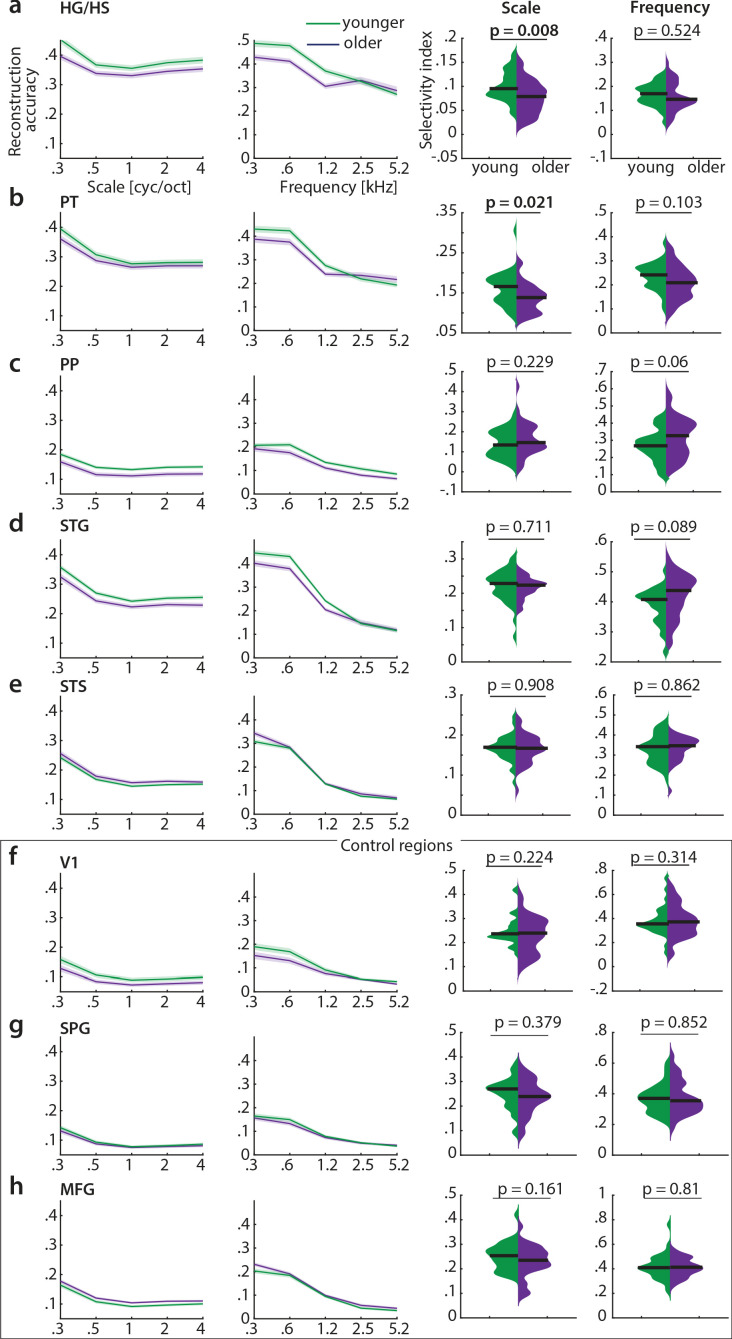
Decoding of spectral scale and frequency in ROIs.Mean (± SE) reconstruction accuracy profiles (left) and selectivity index (right) per age group for spectral scale and frequency in (a) Heschl’s gyrus and sulcus (HG/HS), (b) planum temporale (PT), (c) planum polare (PP), (d) superior temporal gyrus (STG), (e) superior temporal sulcus (STS) and the control regions (f) calcarine sulcus (V1), (g) superior parietal gyrus (SPG) and (h) middle frontal gyrus (MFG). Selectivity index was compared per ROI between age groups using exact permutation test. Black line indicates the median SI. Note that removing the young outlier participant (>2 SD away from the mean) for scale in PT reduces the mean age difference to a still significant SI difference = 0.015, p=0.026.